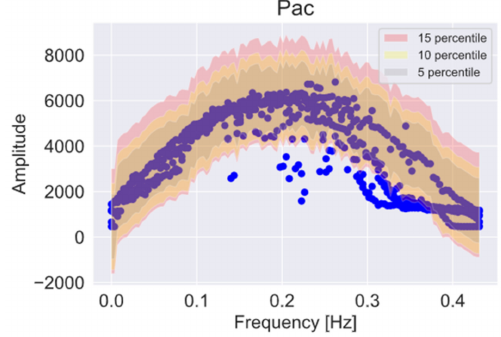
Figure 2. Normality study in Power AC